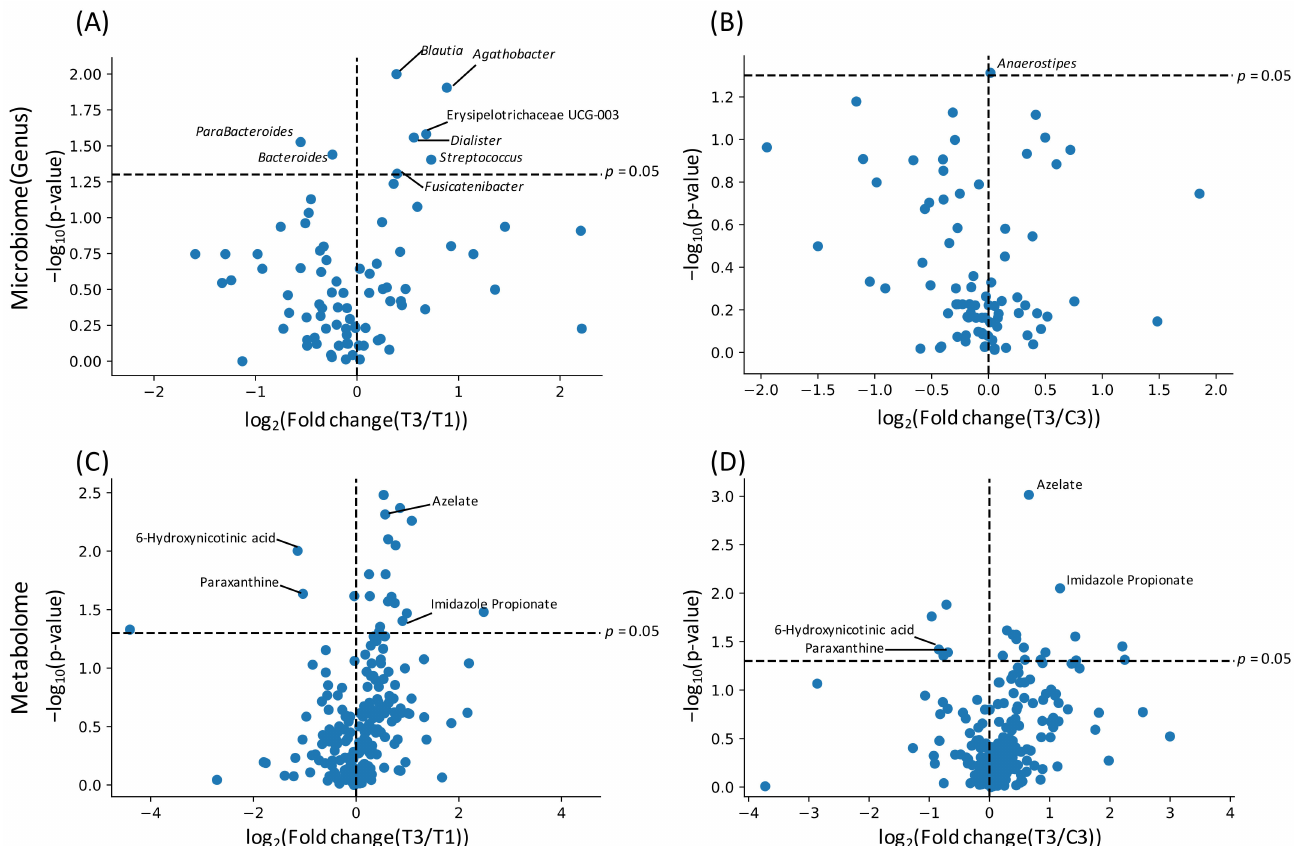
Figure 2. Effect of barley intake on intestinal microbiome and metabolome. X axis indicates log fold change in mean value of corresponding genus/metabolite abundance after 4-week intervention relative to control time point. Y axis indicates logarithmic value of p -value. Each bacterium ( A , B ) and metabolite ( C , D ) were plotted. T1 ( A , C ) and C3 ( B , D ) were used as control time